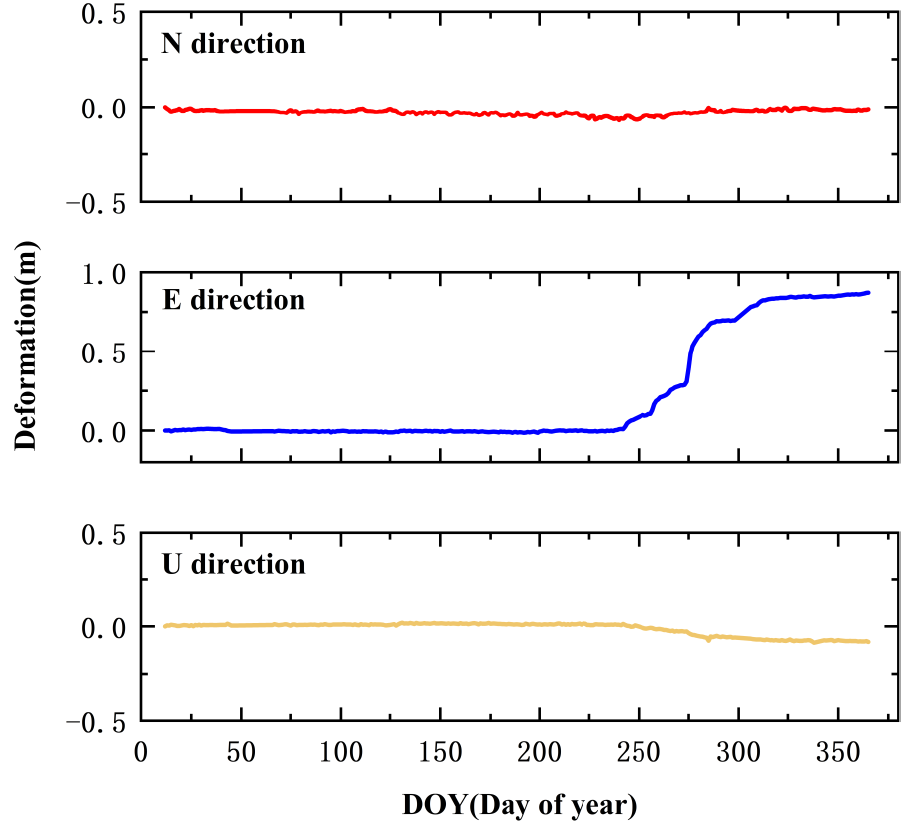
Figure 6. GAMIT baseline solving cumulative deformation time series.